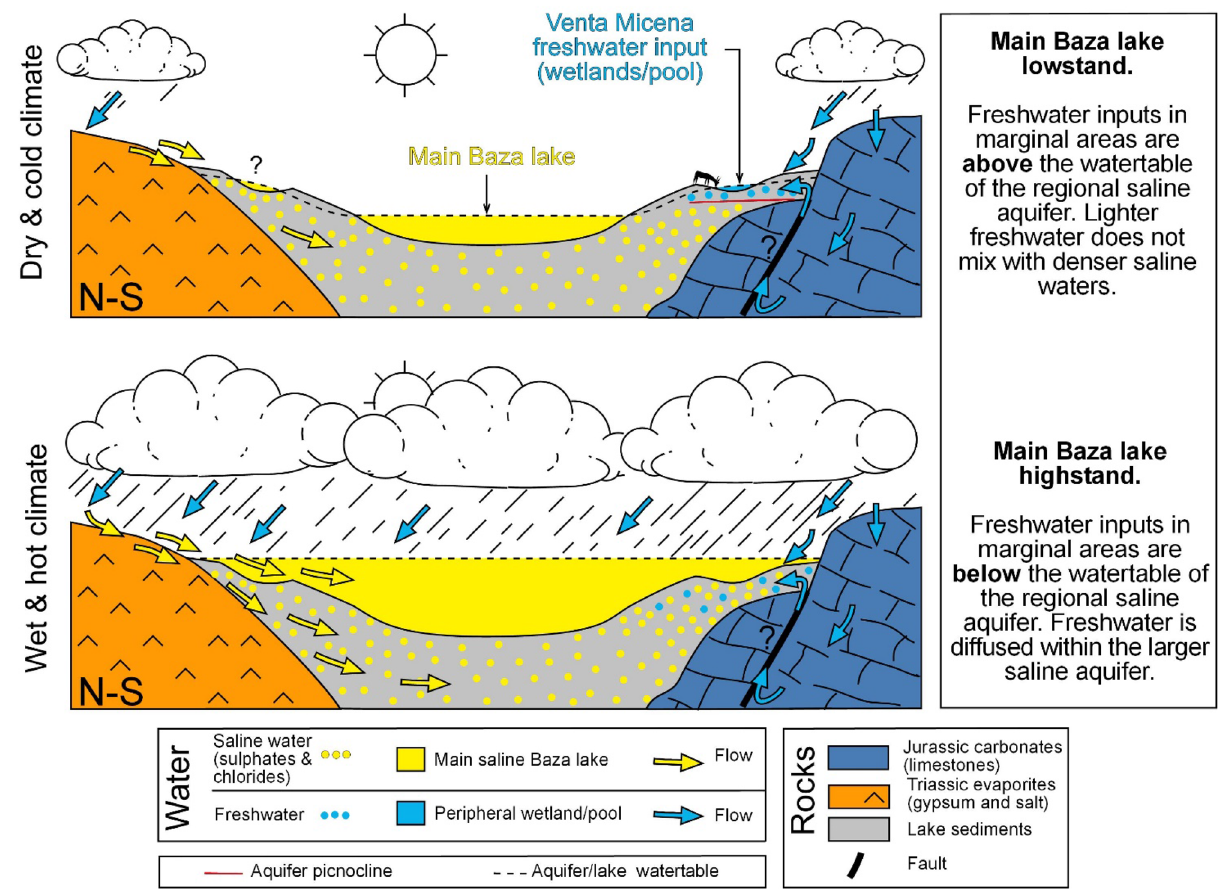
Figure 8. Evolutive hydrochemical model for the succession of the Venta Micena section. The lake highstand belongs to stratigraphic unit B (and also D), while the lake lowstand belongs to unit C (which contains the Venta Micena limestone paleontological sites). The likely input of thermal waters cannot be demonstrated in this study (see text). The vertical scale is exaggerated. The figure was created with Inkscape 1.0.1 (3bc2e813f5, 2020-09-07) software, https:// inksc ape. org/